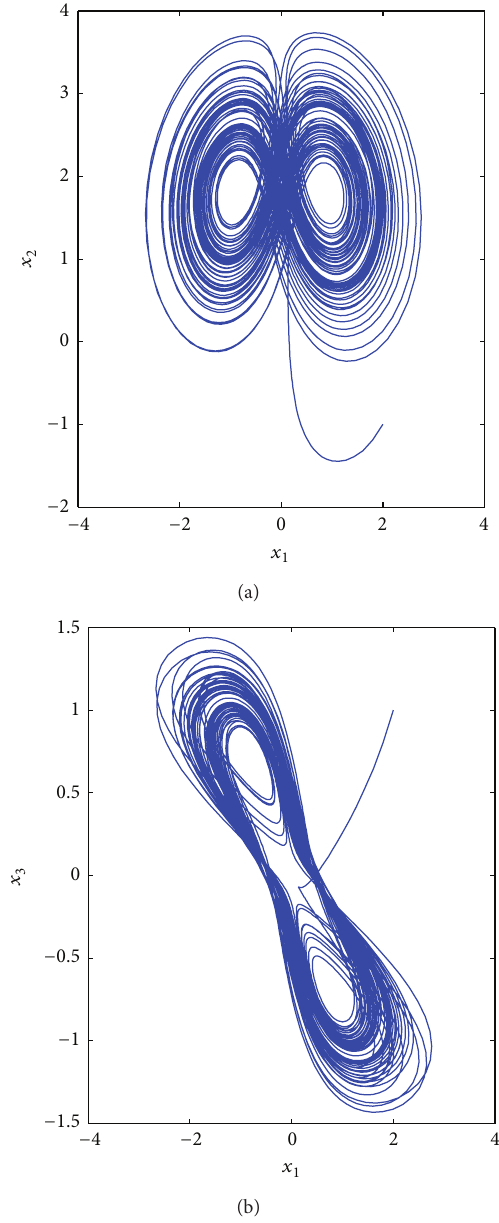
Figure 2: Chaotic attractor of fractional-order financial system with fractional order 𝛼 = 0.90 : (a) 𝑥 1 - 𝑥 2 plane; (b) 𝑥 1 - 𝑥 3